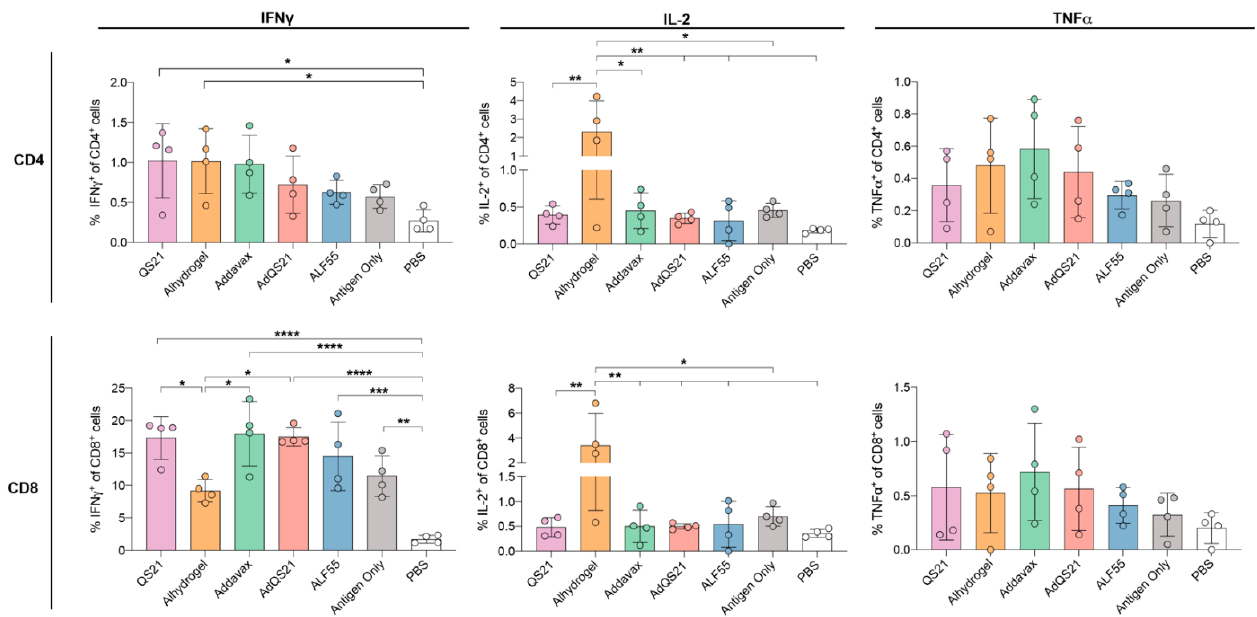
Figure 3. CD4 + and CD8 + T-cell cytokine profiling of mice immunized with HA clamp alongside various adjuvants. Data shown is from day 43 spleen harvest. Data shown is after subtraction of PBS-stimulated cells. Data represents mean ( n = 4) with SD. Statistics calculated using a one-way Tukey’s multiple comparison ANOVA, where * indicates a p < 0.05, ** p < 0.005, *** p < 0.0005, and **** p < 0.0001.